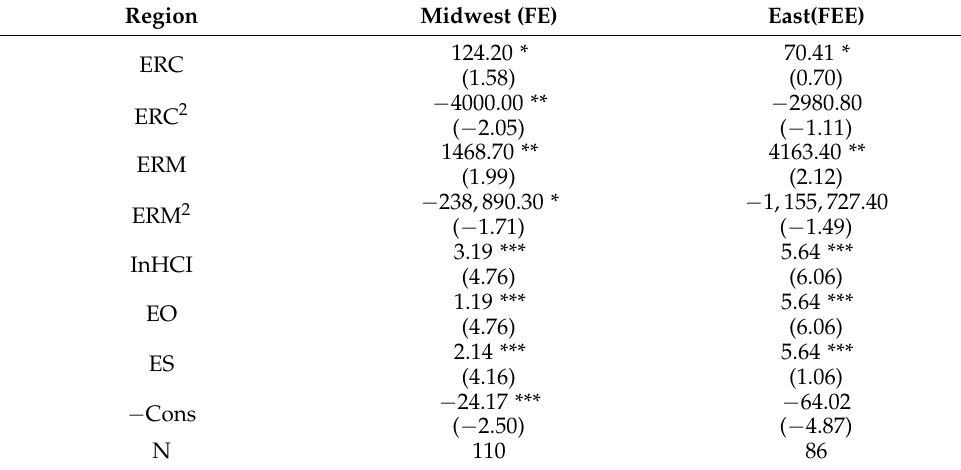
Table 5. Regression